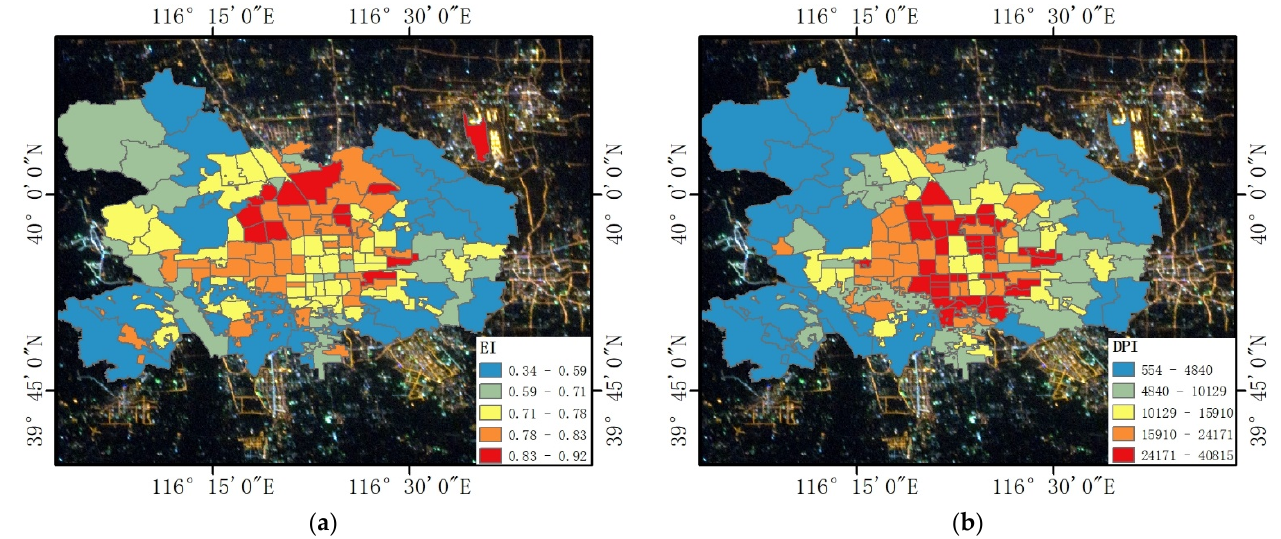
Figure 4. The proportion of the population with junior school education and above (EI) ( a ) and the distribution of population density index (PDI) ( b ) in the research area.